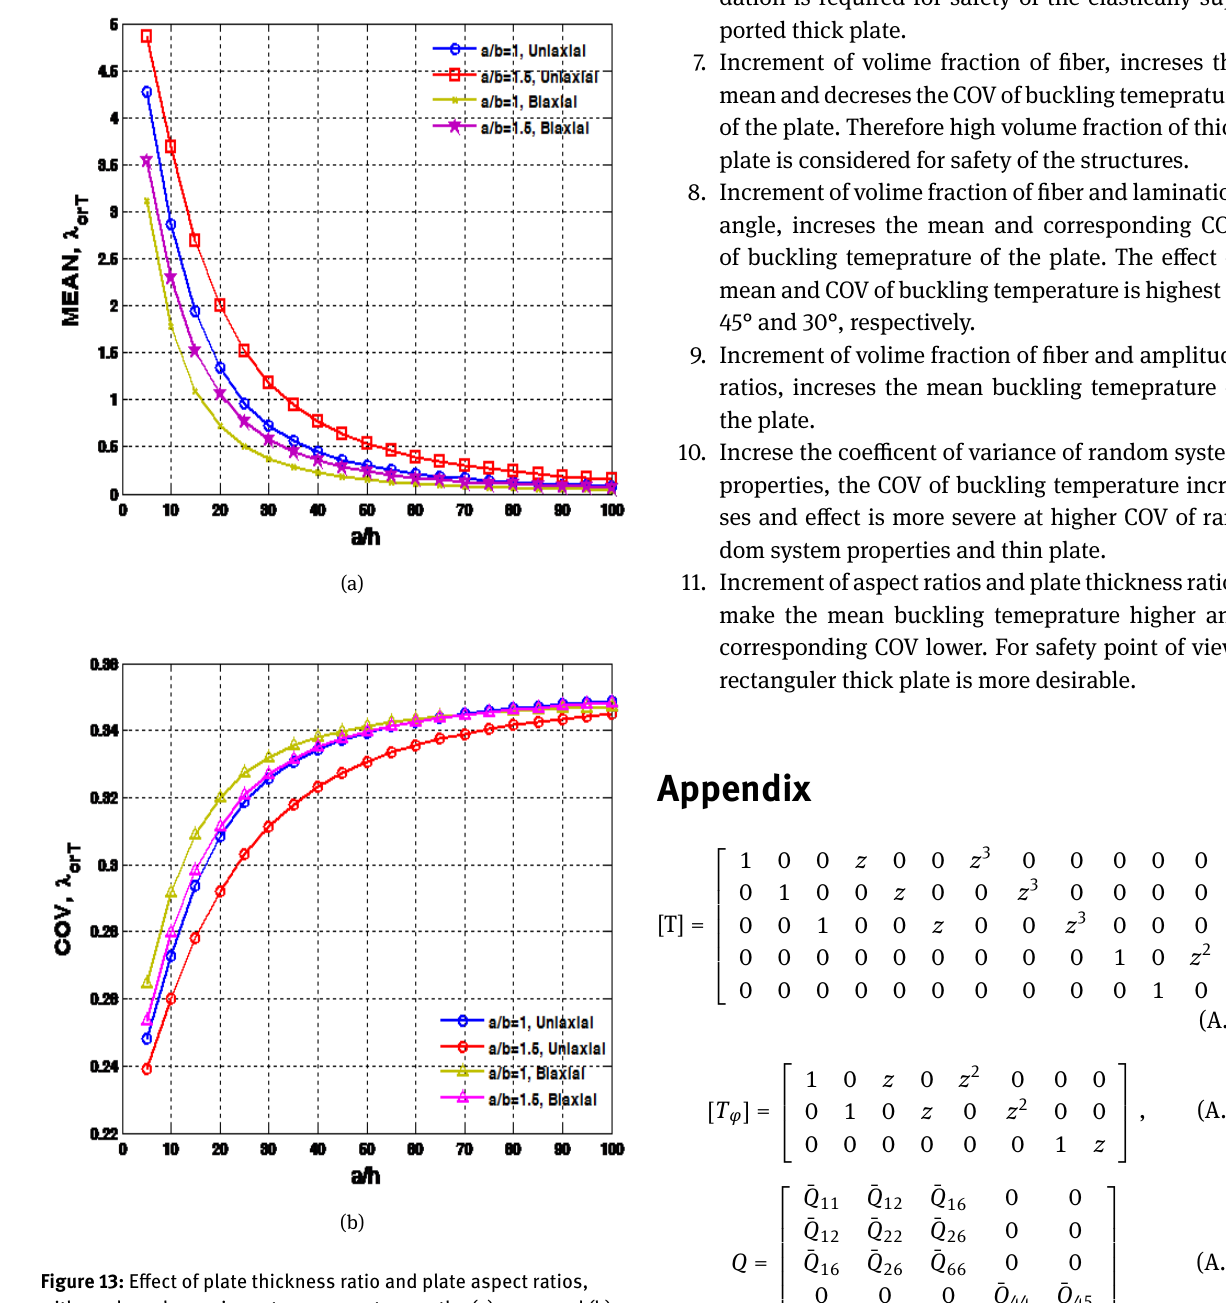
Figure 13: Effect of plate thickness ratio and plate aspect ratios, with random change in system parameters on the (a) mean and (b) COV of buckling temperature of laminated composite plate sub- jected to uni-axial and biaxial